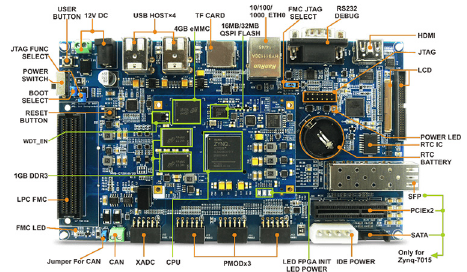
Figure 2 MYD-C7Z020 development board